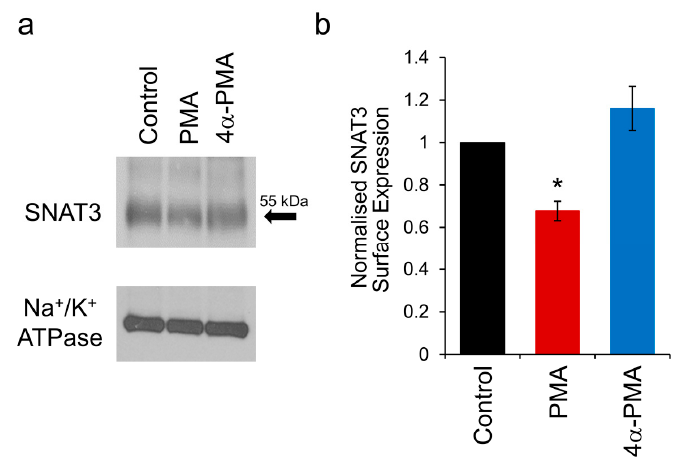
Figure 3. PKC activation internalises SNAT3. ( a ) A representative blot showing surface biotinylation of rat SNAT3 shown by western blot analysis. Slices were treated for 1 h in control, 100 nM PMA or 100 nM 4 α -PMA prior to fixation and biotinylation. The SNAT3 surface expression is indicated by the band at 55 kDa (arrow, top panel). The gel loading control against the Na + /K + -ATPase is shown in the lower panel; ( b ) Quantification from 6 separate experiments shows a significant reduction of rat SNAT3 surface expression by incubation in 100 nM PMA (red bar; n = 6; * p <0.05), whereas the 4 α -PMA control did not show an effect (blue bar; n = 4; p =